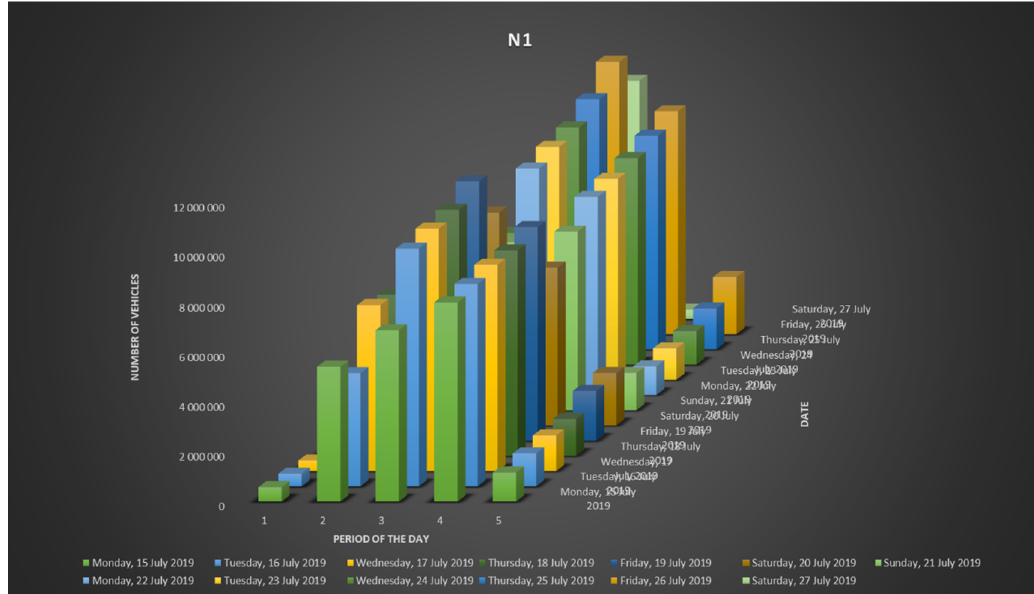
Infrastructures 2022 , 6 , x FOR PEER REVIEW